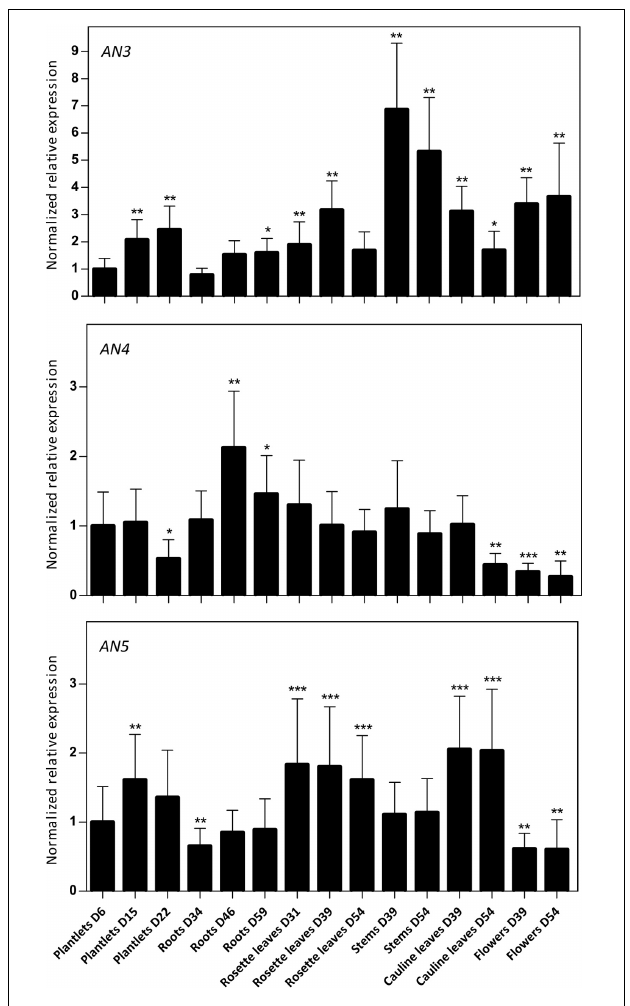
FIGURE 3 | Normalized relative expression of ArathNictaba genes during the development of A. thaliana . The normalized transcript levels are the result of two independent biological replicates ( N = 2). They are presented relatively to the ArathNictaba expression level determined in 6-day-old plantlets. Bars represent the mean ± SE normalized relative expression and asterisks indicate statistically significant differences to the expression level of ArathNictaba in 6-day-old plantlets ( ∗ p ≤ 0.05, ∗∗ p ≤ 0.01, ∗∗∗ p ≤ 0.001; REST